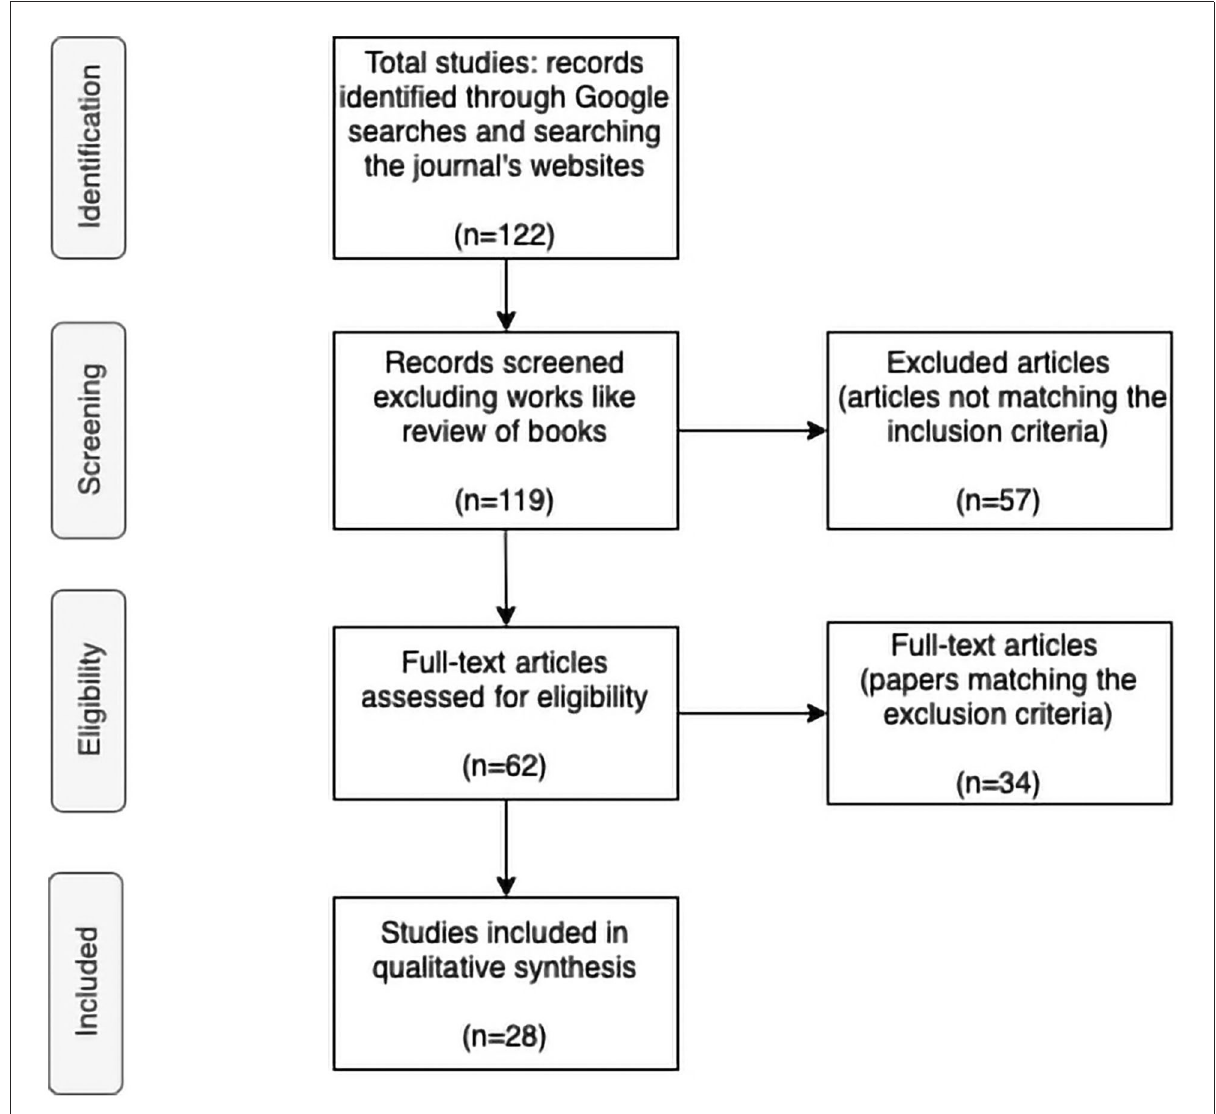
FIGURE1 Flow chart according to the PRISMA declaration (Moher et al.,